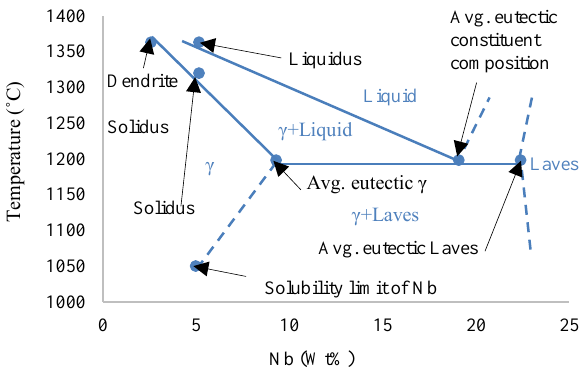
Figure 1: Solidification diagram for IN718